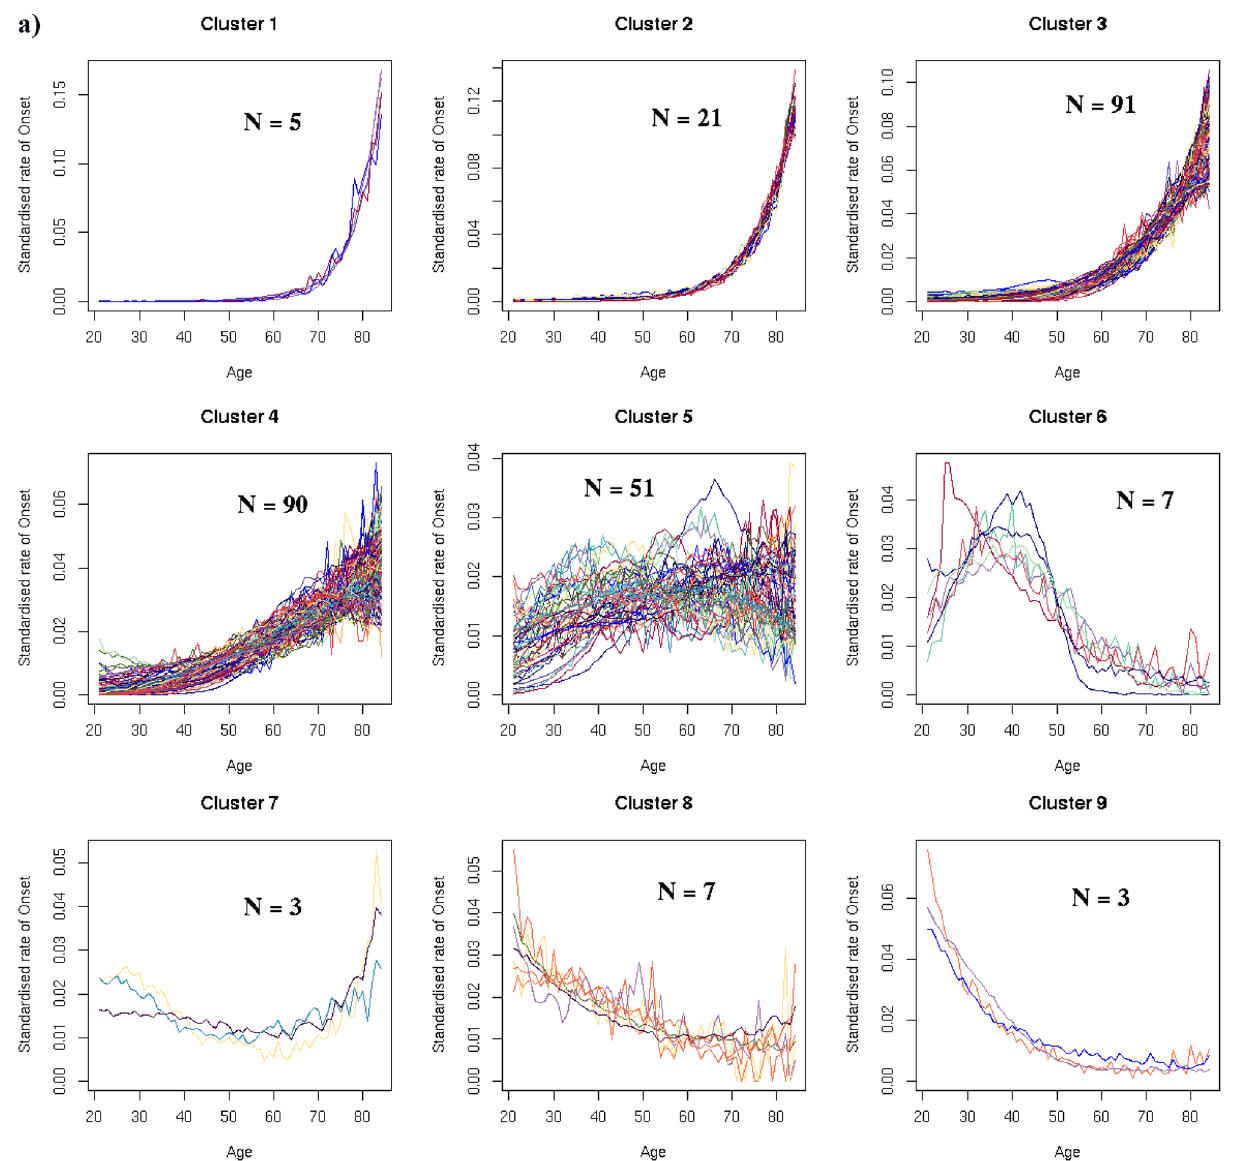
Figure 2. ( a ) In a data-driven approach, hierarchical clustering techniques were used to derive nine clusters of standardised age-specific rate of disease onset curves. The y-axis scales differ for each cluster. N (number of conditions in each cluster) is indicated in each cluster plot. ( b ) Age-specific rate of onset curves (not standardised) for examples from each cluster. The y-axis scales differ for each disease. The number of individuals between the ages of 20 and 85 years with the disease (n) is indicated in each